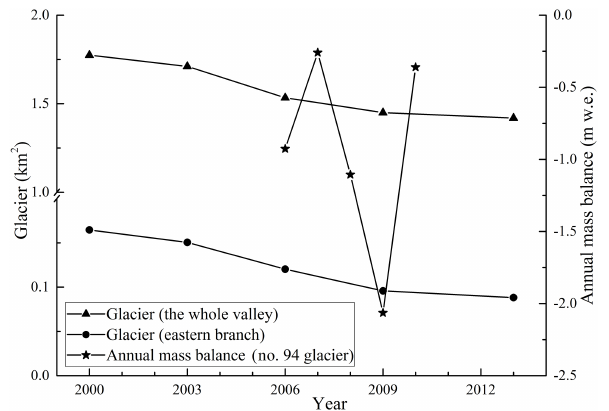
Figure 7. Changes in glacier over time and the measured annual mass balance of the Parlung No. 94 Glacier (mass balance was edited from Yang et al., 2016).